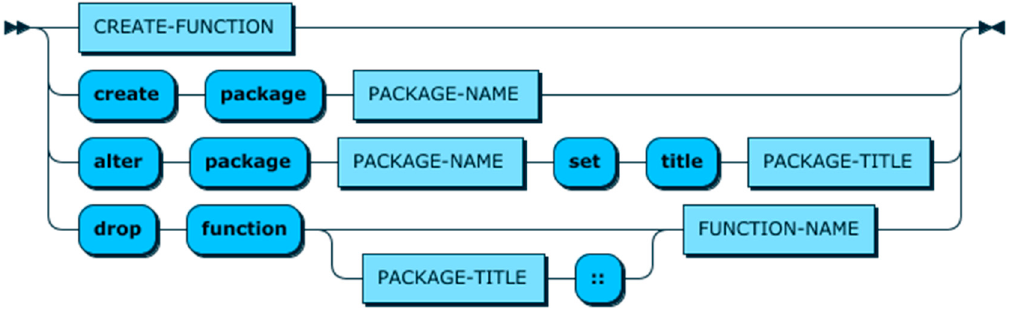
Figure 16. CDL production rule.